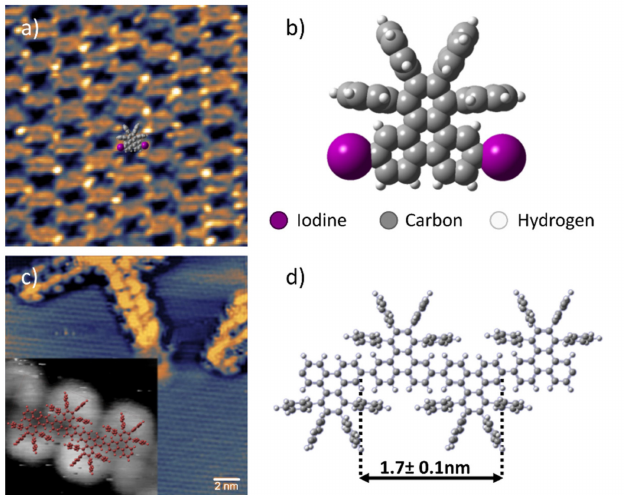
Figure 1. Conventional versus activated deposition. ( a ) STM image of DITTP conventionally de- posited onto I-Ag(111) and ( b ) molecular structure of highly non-planar DITTP. ( c ) STM image of DITTP deposited onto I-Ag(111) via the RaDeS (the insert shows a close-up) and ( d ) corresponding model of the covalent polymer chain. Image parameters: ( a ): 11 × 11 nm 2 , 93 pA, 1.13 V, pA, and 0 V; ( c ): 20 × 20 nm 2 , 62 pA, and 2.5 V; and insert: 3 × 4 nm 2 , 92 pA, and 2.7